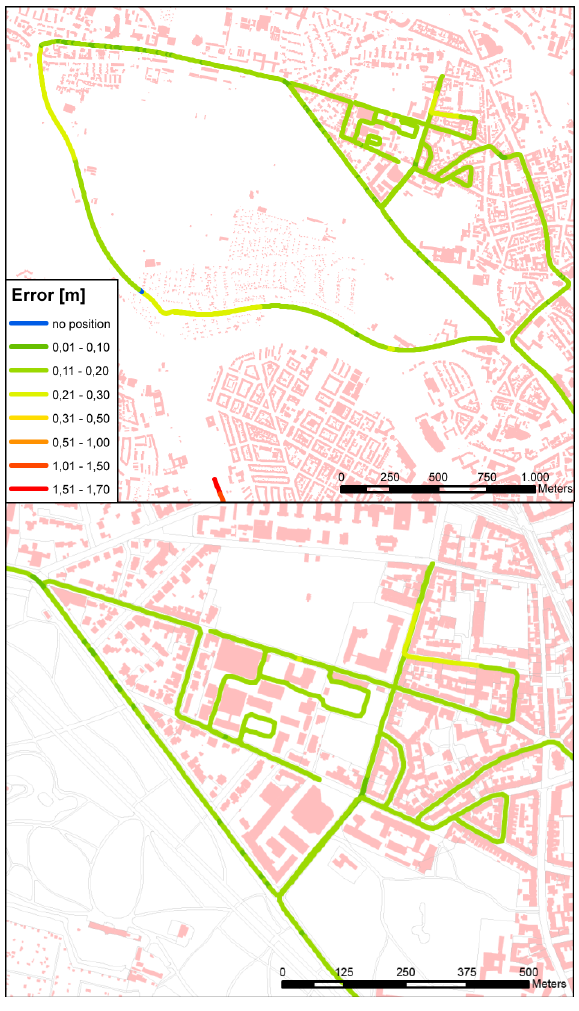
Figure 8. Map of accuracies using a precise IMU for filtering for a camera system with 100° opening angle. The accuracy along the highway (upper picture, left) depends on the direction of travel (from south to